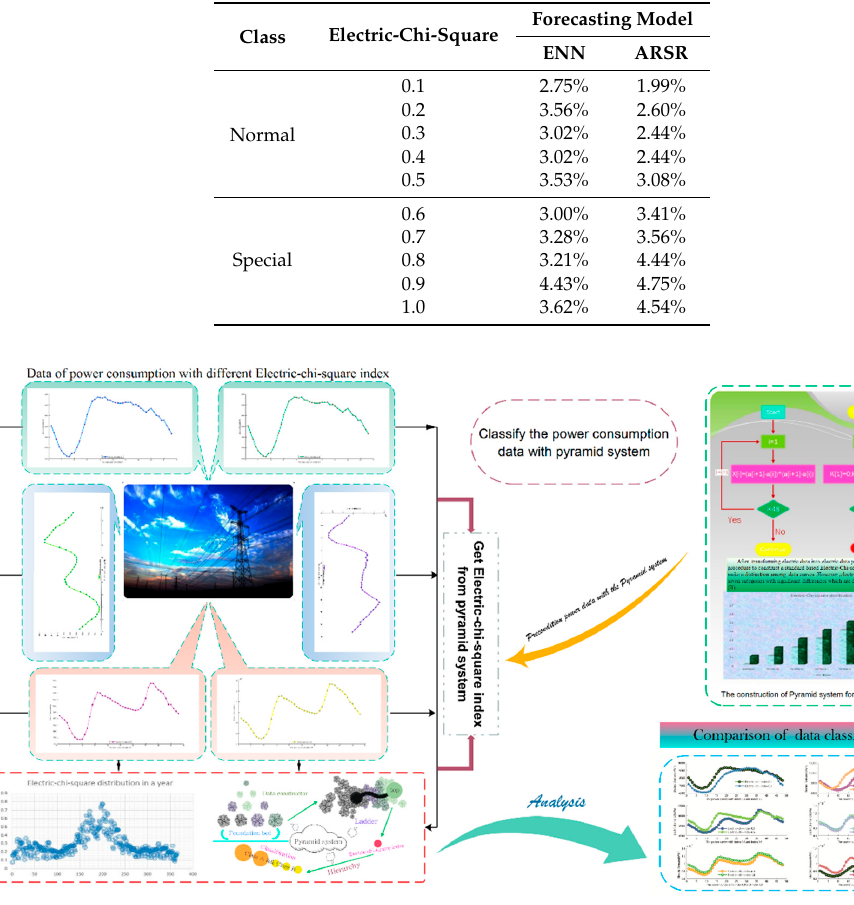
Figure 4. Pyramid system of data classification.